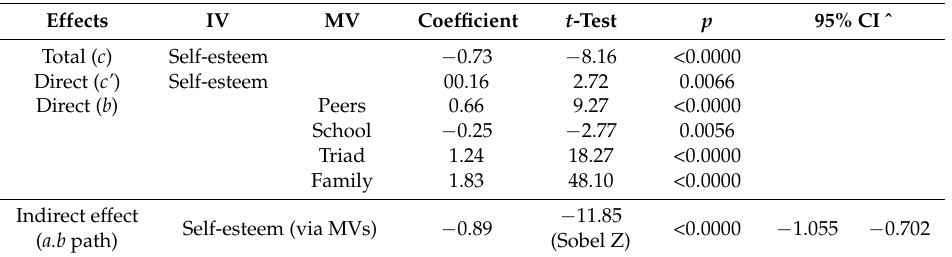
Table 5. Mediating analysis of contextual factors on the relationship between self-esteem and violence of school students.